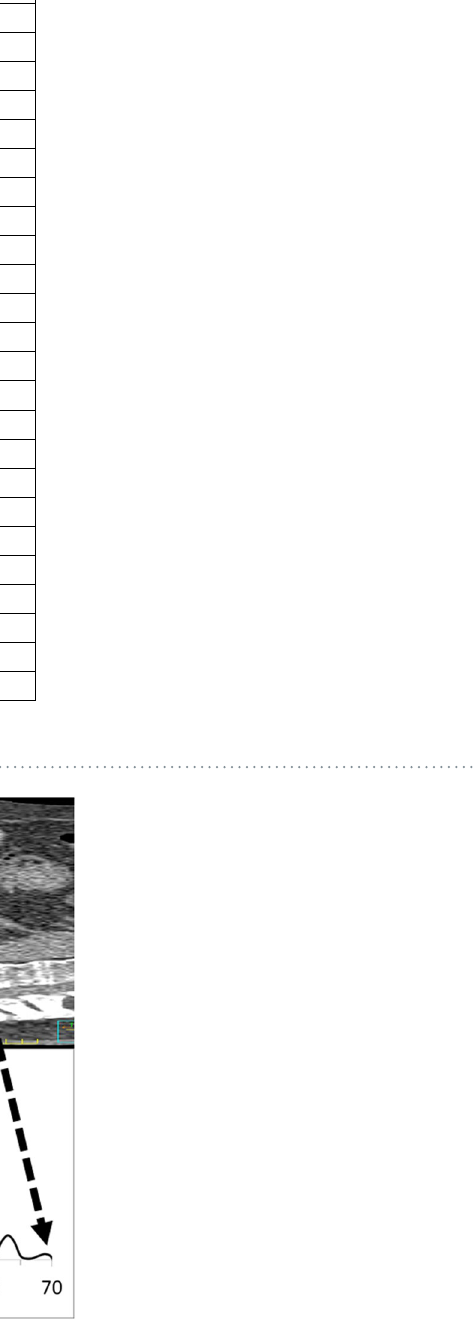
Figure 1. An example of esophageal expansion. (Top) Example patient thoracic CT with a colorwash of the radiation therapy dose distribution and esophageal segmentation (blue). (Bottom) Axial profile of esophageal expansion calculated at along the superior-inferior direction of the esophagus. The shaded red box is the esophageal subvolume region of analysis. Note the high expansion in the corresponding region of high radiotherapy